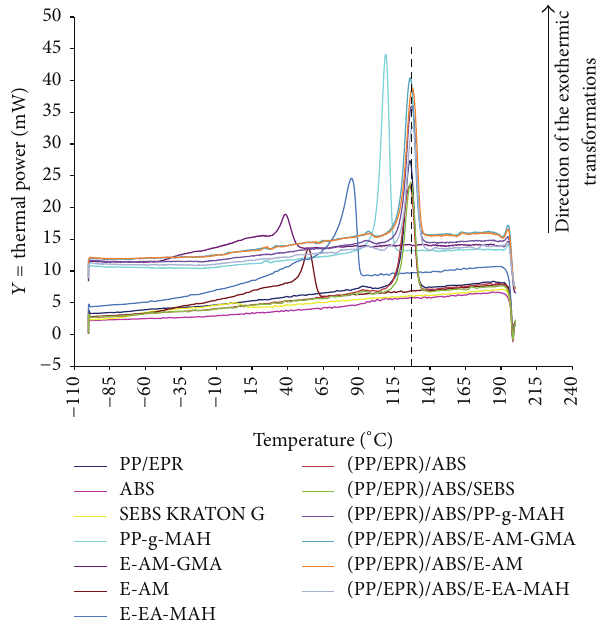
Figure 8: DSC curves in the direction of the exothermic transfor- mations of components and mixtures (PP/EPR)/ABS/compatibil- izer (93.5)/5/1.5, for the second thermal cycle. For about 15mg of sample. 1 graduation 𝑌 = 5 mW.